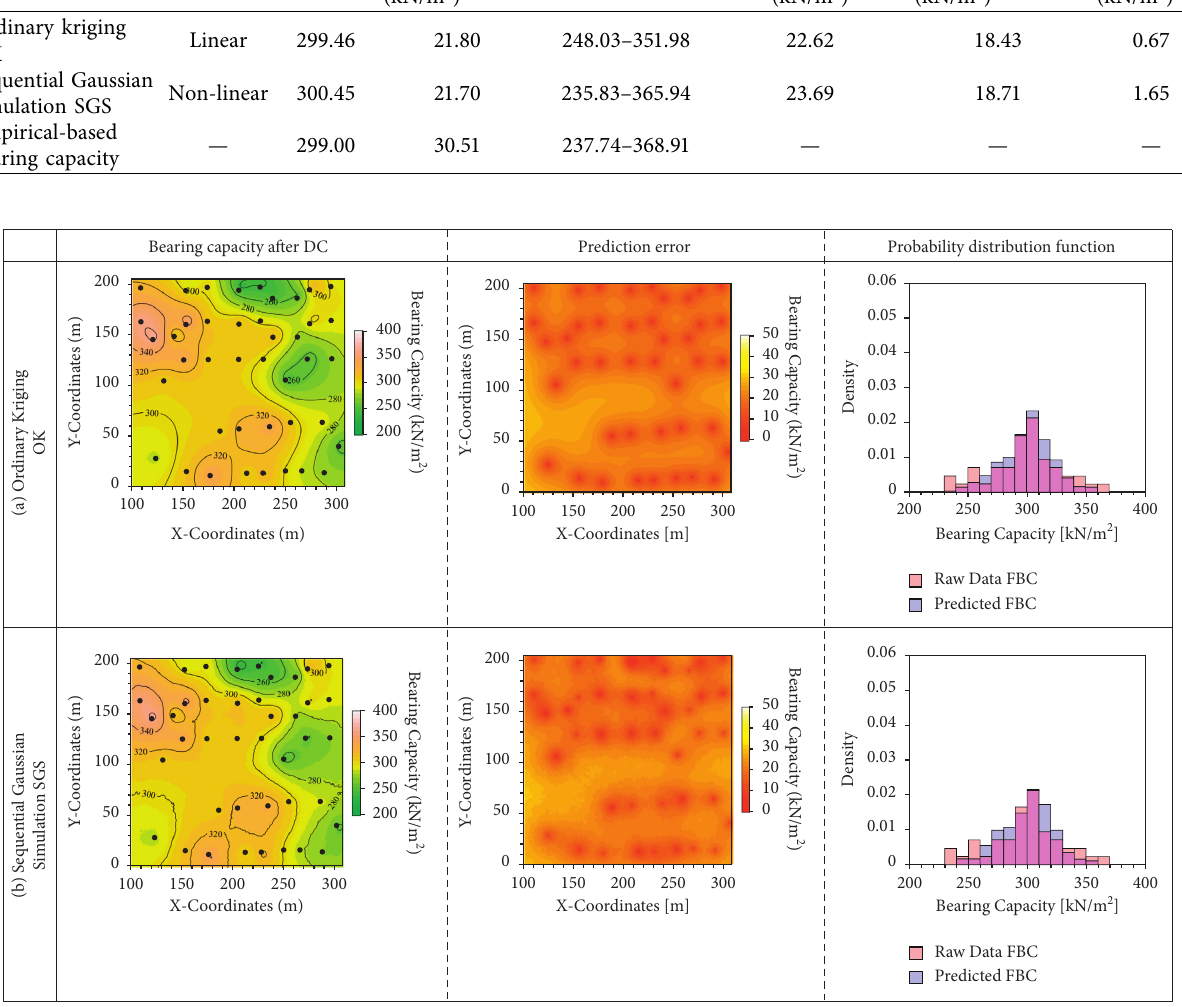
Figure 6: Spatial distribution maps for estimated bearing capacity after DC, prediction error for bearing capacity after DC, and probability distribution function (PDF) for geostatistical models after the dynamic compaction. Results are obtained using: (a) Ordinary kriging (OK) and (b) Sequential Gaussian Simulation (SGS). Note . The location of the SPT-N boreholes after DC is indicated with black circular